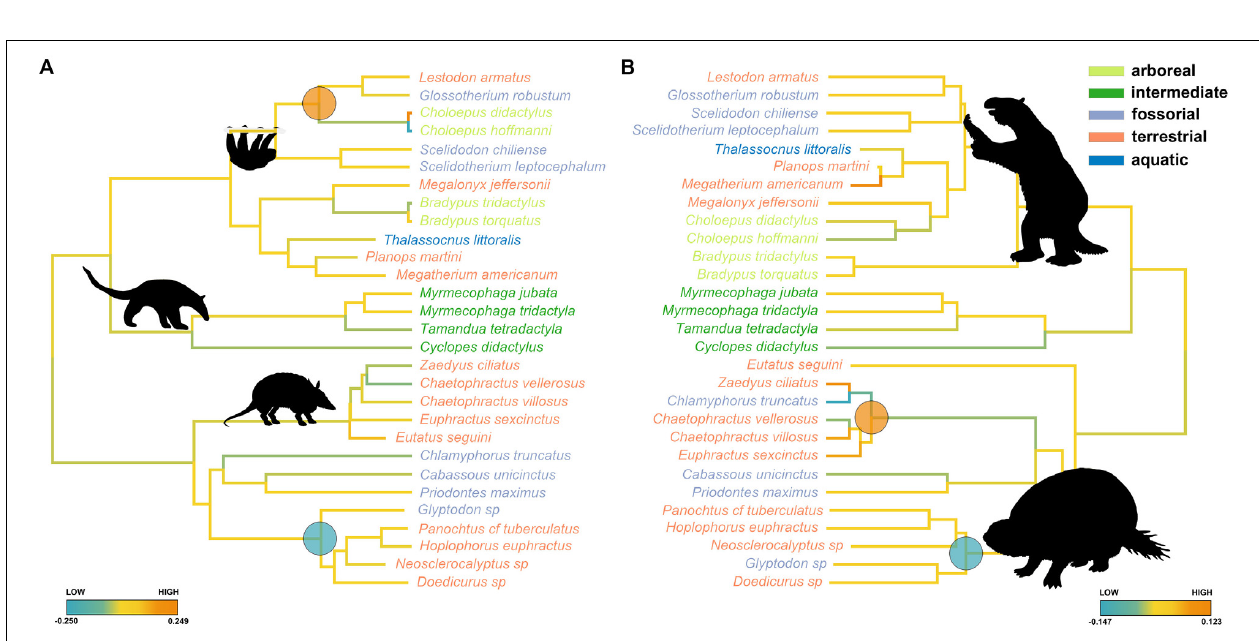
FIGURE 4 | Evolutionary rates (color coded) for the Xenarthra humerus size along the molecular (A) and morphological (B) tree. Species names are coded according to locomotor categories. Large dots at nodes represent clade shifting (blue = low, orange = high).